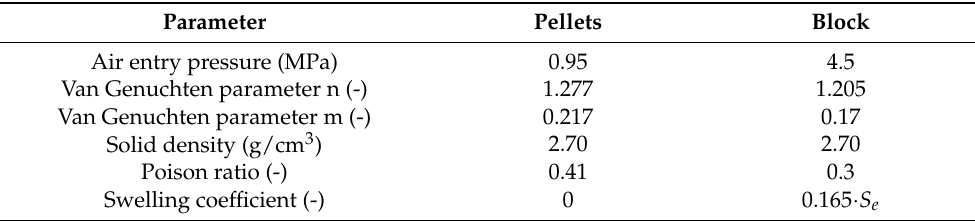
Table 2. Values of HM parameters for the bentonite block and pellets used in the numerical model.